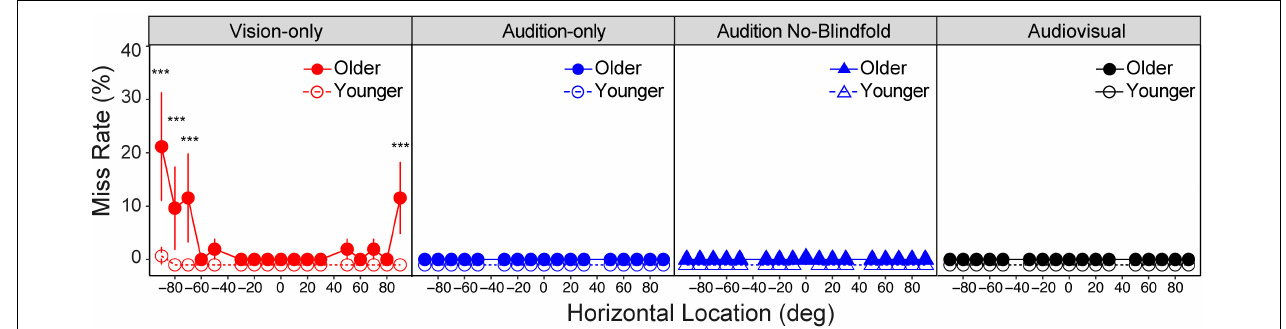
FIGURE 3 | Miss rate. Miss rate in the four conditions for the older and younger groups, respectively. Note that most of the dots overlapped at 0 miss rate, therefore the data for the two groups were slightly offset vertically to make them more distinguishable. The error bars represent standard errors. Statistical asterisks represent significant difference between the older and younger groups. *** p <